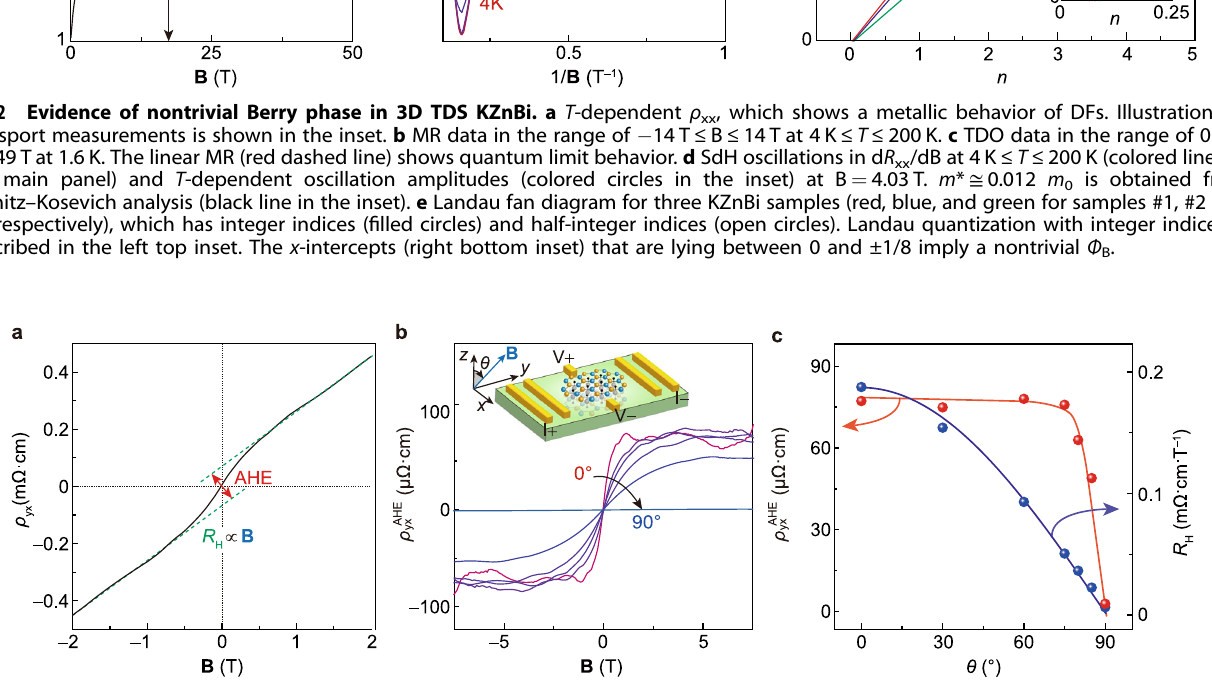
Fig. 3 Unusual angle-dependent anomalous Hall effect. a The ρ yx in the range of − 2 T ≤ B ≤ 2 T at 4 K. A linear background (green dashed lines) is attributed to the ordinary Hall coef fi cient ( R H ) and the anomaly near B = 0 (red two-headed arrow) is responsible for the ρ AHE . b θ - yx in the range of 0° ≤ θ ≤ 90°. Illustration of θ -dependent Hall measurements is given in the inset. c Unusual θ -dependent dependent ρ AHE yx (red dots and line) in contrast to conventional θ -dependent R H (blue dots) with a cosine pro fi le (blue saturation of ρ AHE yx Tuning of Ω k and θ -dependent AHE diagram (Fig. 2e) by plotting the maxima (solid balls) and minima (open balls) of the SdH oscillations as integer and half- The Ω k emerges and acts like an effective B in the 3D TDS when integer indices, respectively. A linear extrapolation of the time-reversal symmetry is broken, giving net anomalous Hall relation between 1/B and LL index gives the intercept value current induced by the transverse velocity ( v A = E × Ω k ) in the of | γ – δ | at zeroth LL. For the measured samples, the intercept electrical fi eld (E) (refs. 5,15 ). To verify the AHE in the nonmagnetic values were in the range of the nontrivial Φ B (inset of Fig. 2e, 3D TDS KZnBi, we measured the Hall resistivity ( ρ yx ) in the range of see Supplementary Figs. 2 – 4 for MR and SdH oscillations), − 2 T ≤ B ≤ 2 T at 4 K (see Supplementary Fig. 5 for the ρ yx in the implying the presence of the topologically nontrivial state in whole measured range of − 14 T ≤ B ≤ 14 T) as plotted in Fig. 3a. It the KZnBi. Later, combined with AHE and NMR data, the state of is clear that the ρ yx shows the kink around zero B, indicating the the nontrivial Φ B is revealed as the time-reversal-symmetry occurrence of AHE due to the Ω k . We note that the easily broken 3D TDS state.